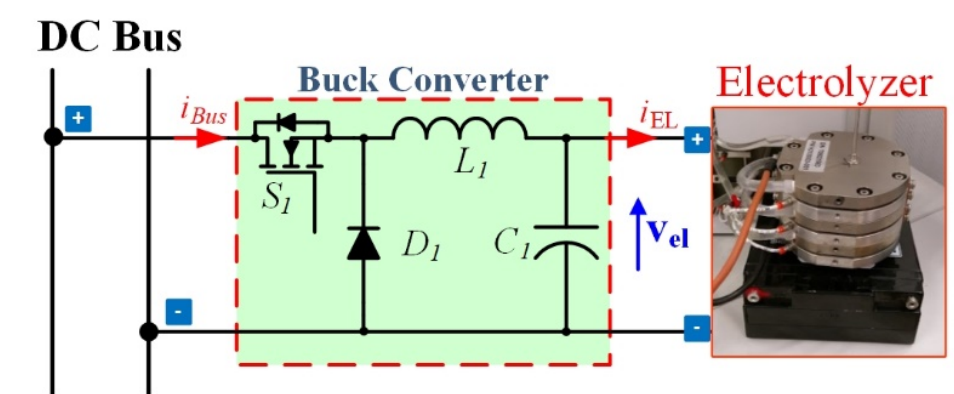
Figure 9. Hydrogen production systems with DC micro grid system.